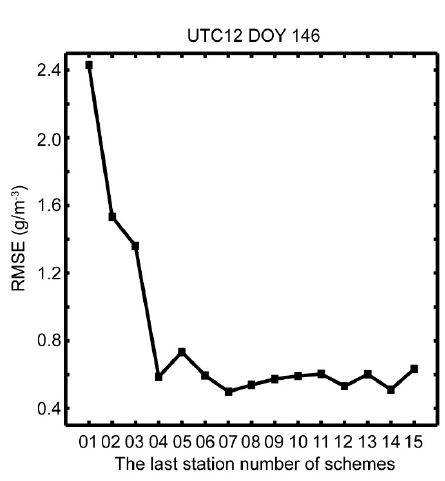
Remote Sens. 2019 , 11 , x FOR PEER REVIEW